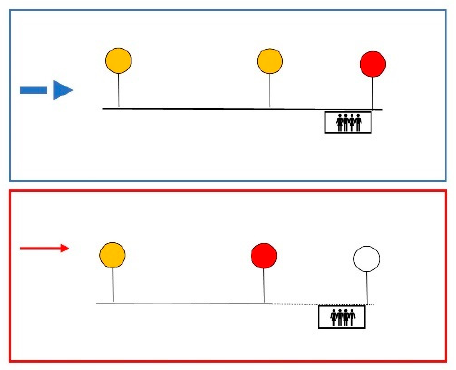
Figure 6. The yellow aspect in the deviating approach (bottom) is at the same location as the yellow aspect during standard approach towards the station (top). During both approaches, the cue is the same (yellow) and the location is the same. The station stop is shown by a rectangle with passengers. The second main situation where a specific signal is often yellow is when that signal often functions as a speed limit indicator in front of a switch (Figure 7). The standard, more common situation is shown at the top (blue). Below this is the deviating situation (red). In is visually